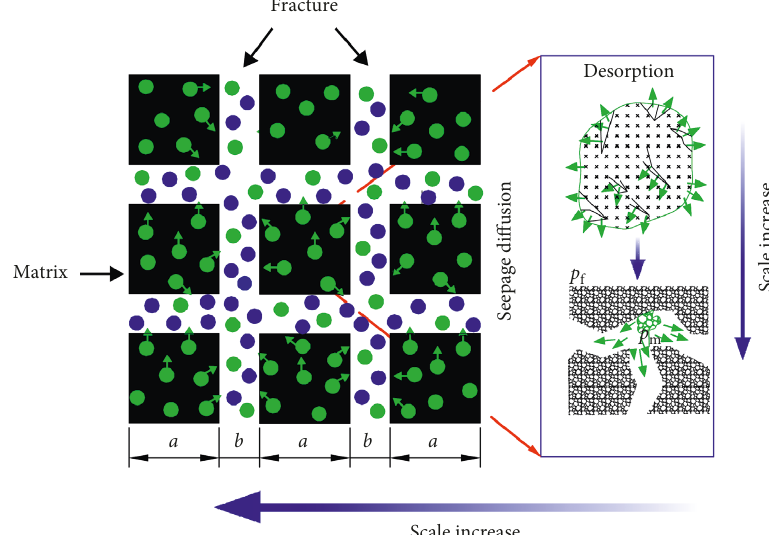
Figure 3: Gas migration modes from matrix to